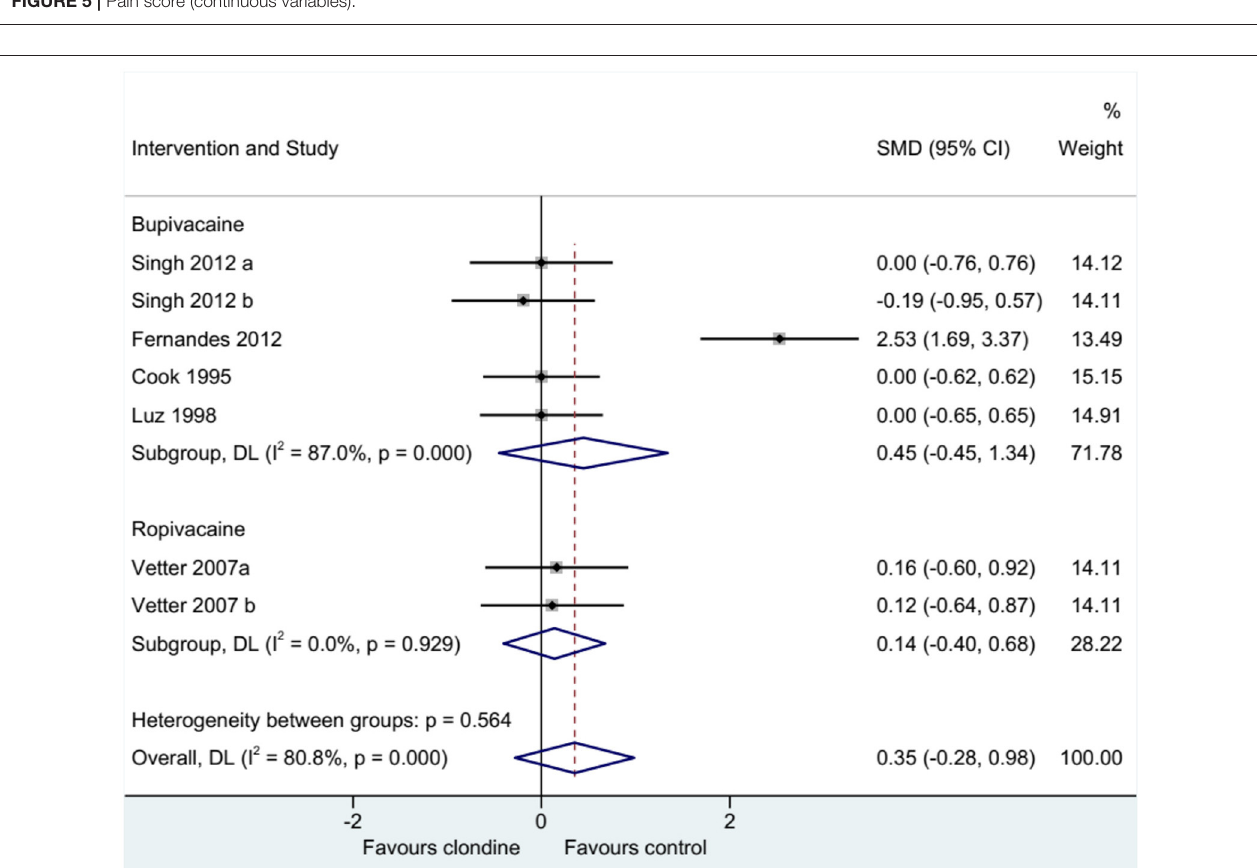
FIGURE 6 | Subgroup analysis of pain score by local